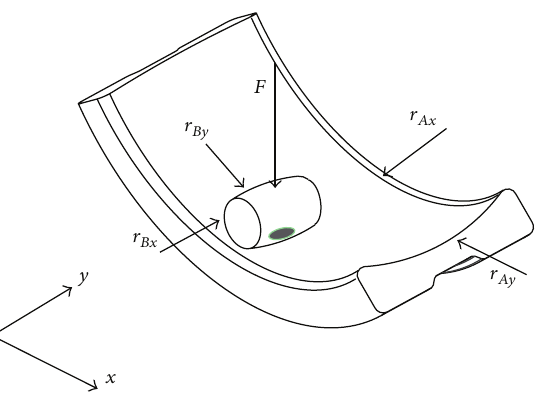
Figure 2: Elliptical contact conjunctions.